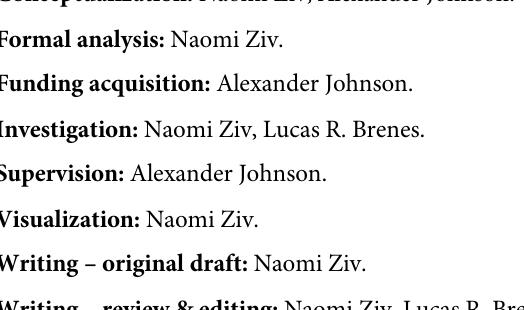
S1 Video. Example of time-lapse movie of a switching event Movie corresponds to “Exam- ple 1” in Fig 1D. Movie is shown twice; in the second repetition, tracked cells are labeled. This strain contains the Wor1-GFP fusion protein. S2 Video. Example of time-lapse movie of a switching event containing a mixed-fate pedi- gree Movie corresponds to example in Fig 3C. Movie is shown twice; in the second repeti- tion, tracked cells are labeled. This strain contains the Wor1-mGFP fusion